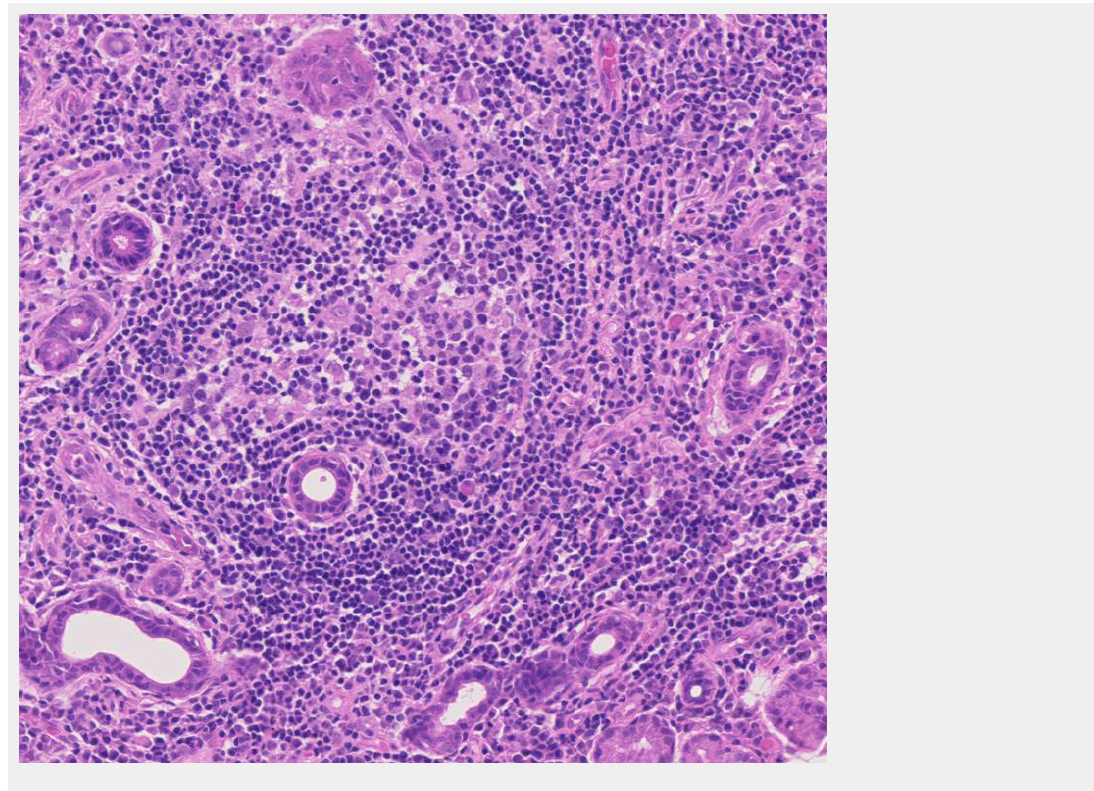
Figure 4 Germinal centre-like structure in a primary Sjögren’s syndrome salivary